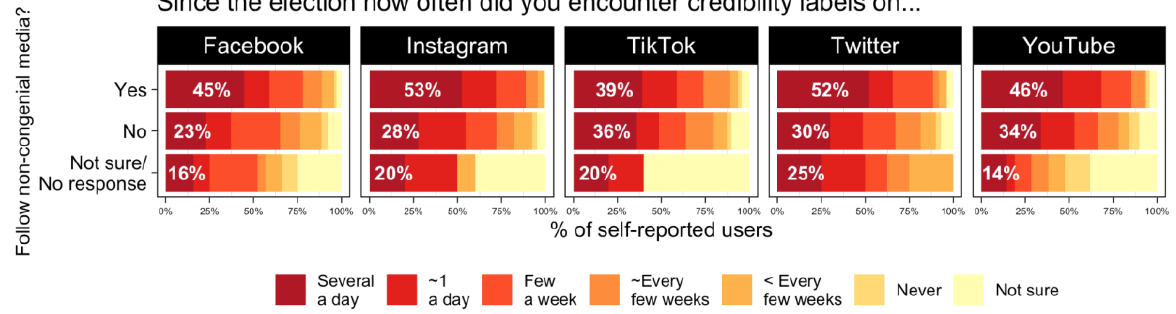
Figure 5. Frequency of exposure to credibility labels by non-congenial news consumption. This grid shows percentage (x-axis) of responses in each exposure frequency category (y-axis) for each respondent group (rows) and social media platform